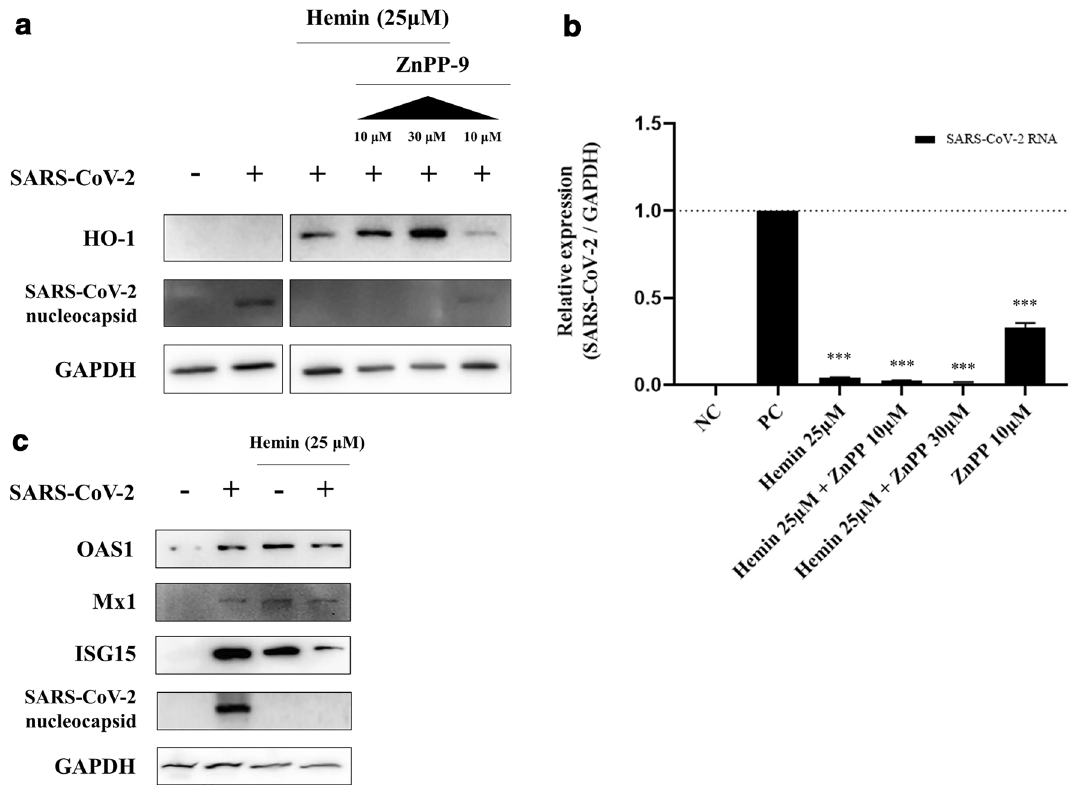
Figure 5. Antiviral efficacy via ISG induction, and not enzymatic action of hemin. Effect of ZnPP-9 (selective inhibitor of HO-1 enzyme activity) on SARS-CoV-2 infection. Vero76 cells were treated with/without hemin or ZnPP-9. The concentration of hemin was 25 μM. ZnPP-9 did not reverse the antiviral effects of HO-1 induced by hemin. ( a ) ZnPP-9 induced HO-1 protein expression even in the absence of hemin (also see Supplementary Fig. S4e), and ( b ) HO-1 induction also suppressed the replication of the virus. ( c ) ISG induction by SARS- CoV-2 and hemin (also see Supplementary Fig. S4f, g). The expression of ISG proteins could be induced only under SARS-CoV-2 infection; however, the ISG proteins could not completely suppress viral replication. Treatment with hemin also induced the expression of ISG proteins and inhibited the replication of the virus. *** P <